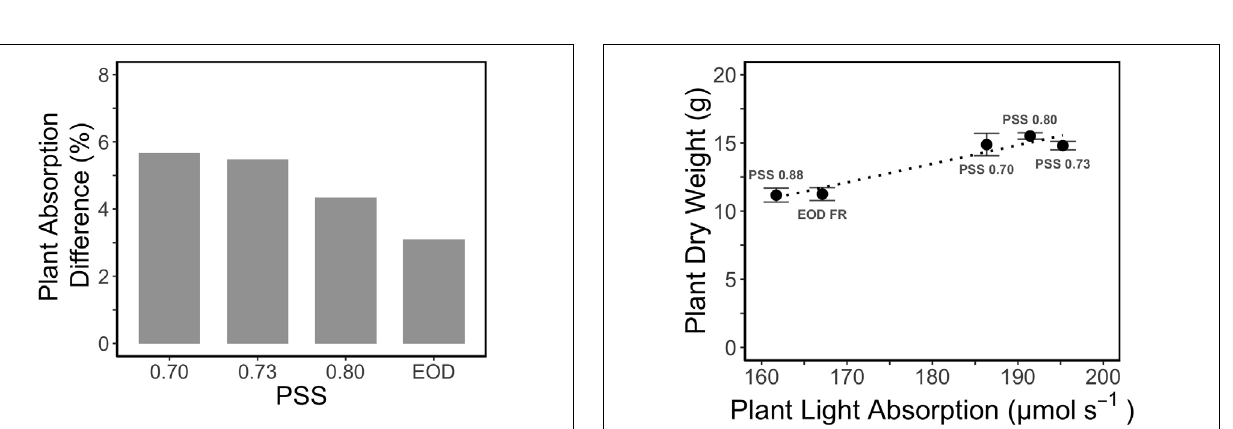
was stimulated. This is a normal, but usually